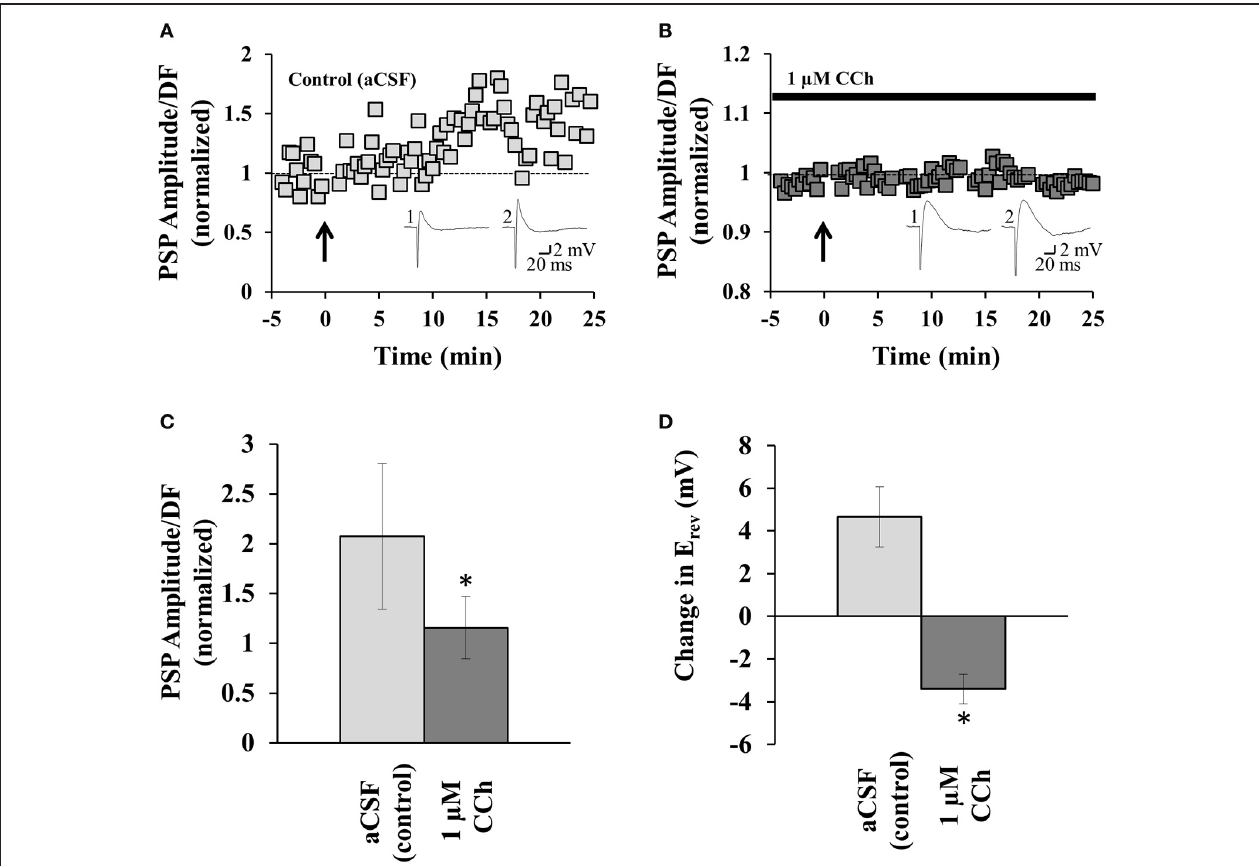
plasticity induction (1), and from the end of the recording period (2). (B) Similar example recording to that in (A) , but for a neuron perfused with 1 µ M CCh. (C) Summary of all experiments similar to those in (A) ( n = 9) and (B) ( n = 4). (D) Summary of the change in E rev for neurons in aCSF or CCh. ∗ indicates significance ( p < 0 . 001). Error bars represent ± one SEM. Dashed lines indicate normalized pre-induction